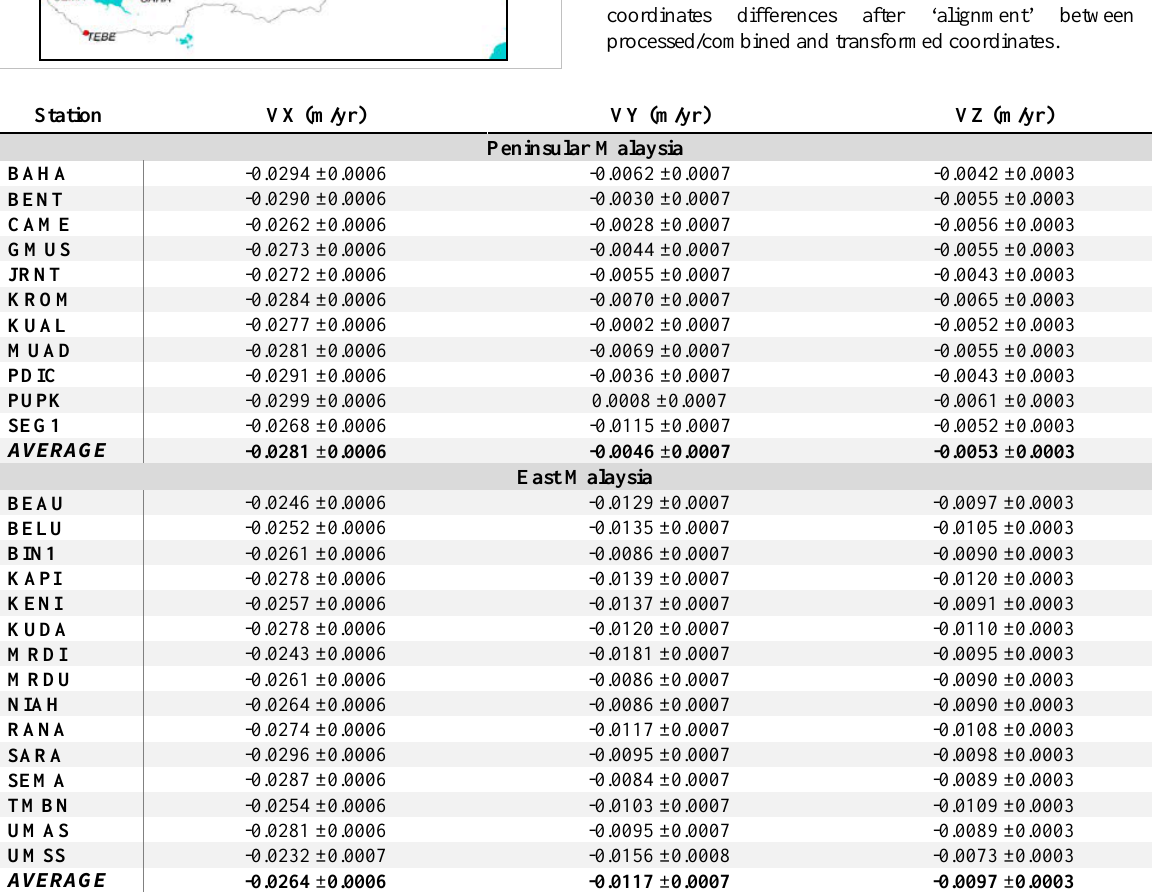
Table 7. Averaged velocities in Cartesian system for Peninsular and East Malaysia. These averaged velocities will then be